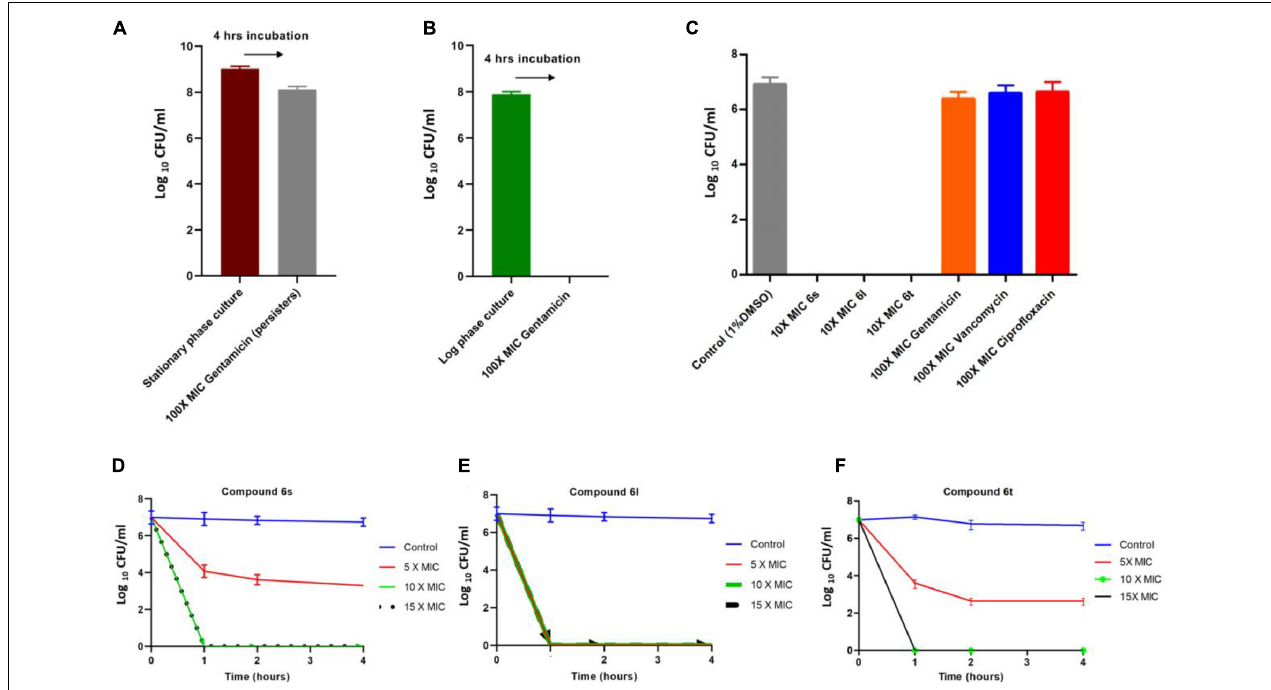
FIGURE 4 | Killing kinetics of compounds against persister MRSA cells: (A) Development of MRSA-3 persister cells. Stationary phase overnight cultures of MRSA-3 were treated with 100 × MIC (62.5 µ g/ml) gentamicin for 4 h and viable drug tolerant persister counts were determined. (B) Gentamicin killing of log phase MRSA-3 cultures treated with 100 × MIC gentamicin for 4 h. (C) Persister MRSA-3 cells were diluted to 10 7 CFU/ml and treated with indicated concentrations of compounds or control antibiotics for an additional 4 h. (D–F) Killing kinetics of compounds 6s (D) , 6l (E) , and 6t (F) against persister MRSA-3 cells. All results are average of three biologically independent experiments.